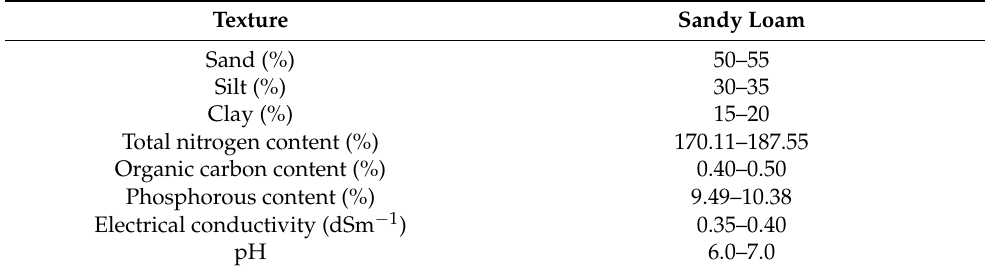
Table 5. Physical and chemical properties of soil at the experimental site.